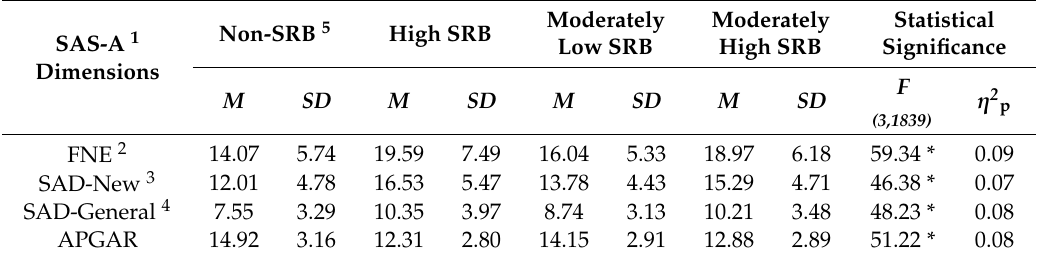
Table 3. Means and standard deviations obtained by the four clusters in SAS-A dimensions. SAS-A 1